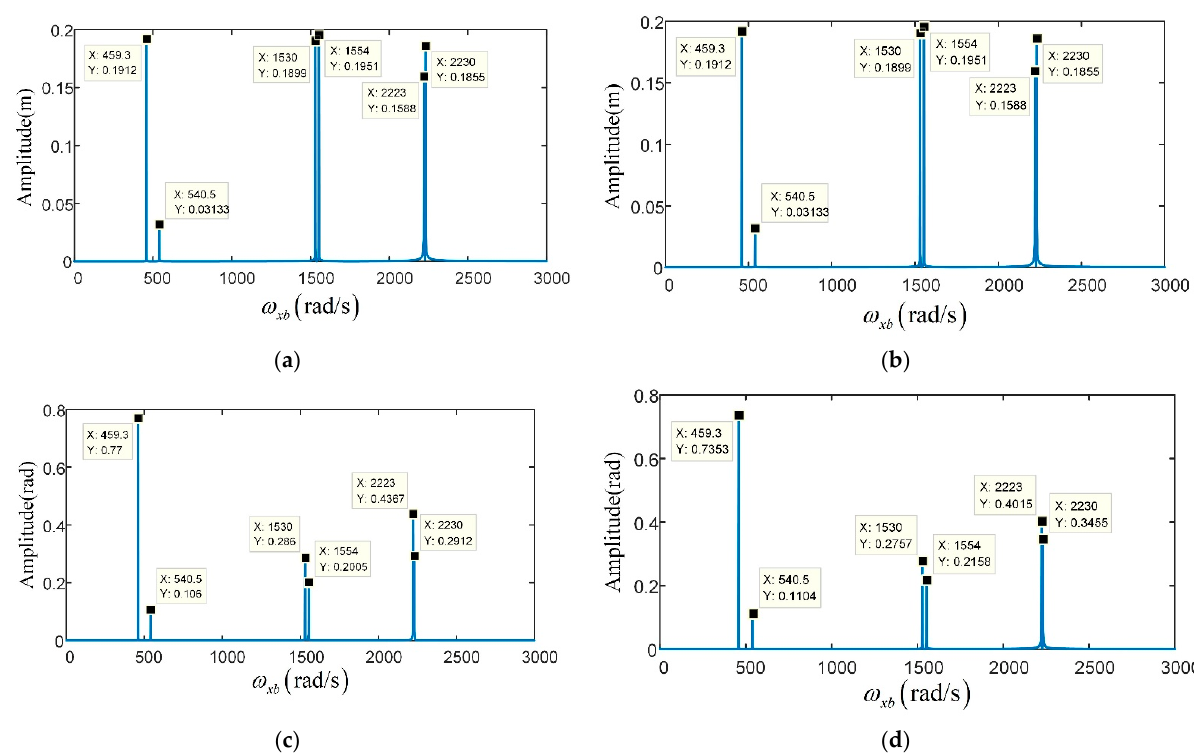
Figure 8. Responses of the counter-rotating dual-rotor system at the disk 1 under harmonic base translations: ( a ) 𝑥 (cid:3031)(cid:2869) ; ( b ) 𝑧 (cid:3031)(cid:2869) ; ( c ) 𝜃 (cid:3031)(cid:2869) ; ( d ) 𝜓 (cid:3031)(cid:2869) .